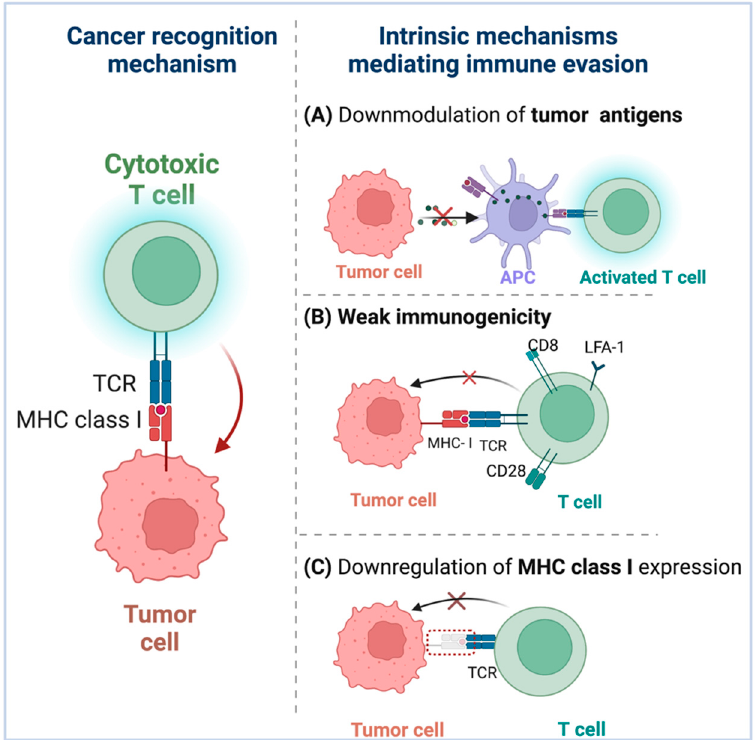
Figure 2. Tumor cells have evolved various strategies for evading immune responses. ( A ) Downregulation of tumor antigens: Certain malignancies lack pre-existing tumor T cell infiltration, allowing them to escape immunosurveillance due to low tumor antigen expression levels, resulting in inadequate APC recruitment and activation. ( B ) Weak immunogenicity: Immune selection permits tumors with weak immunogenicity to avoid immune surveillance and grow preferentially, and the weak immunogenicity of tumor antigens may be owing to incorrect or non-expression of costimulatory molecules on tumor cells. ( C ) Downregulation of MHC-I expression: By evading immune identification by tumor cells, the ability of tumor-associated antigen (TAA)-specific CTLs to kill cancer cells is compromised.